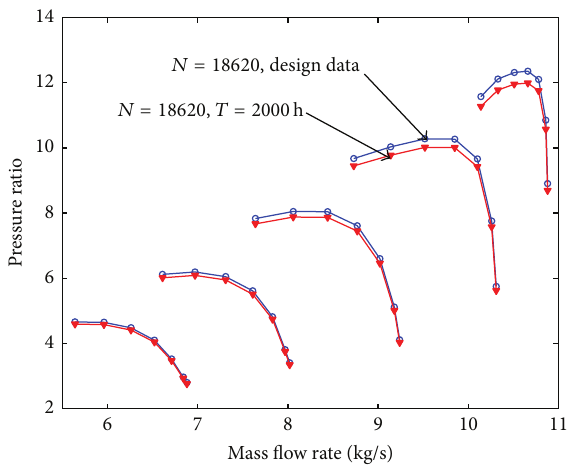
Figure 13: The pressure ratio curve with 2000 hours due to fouling with different relative fouling severity coefficient.